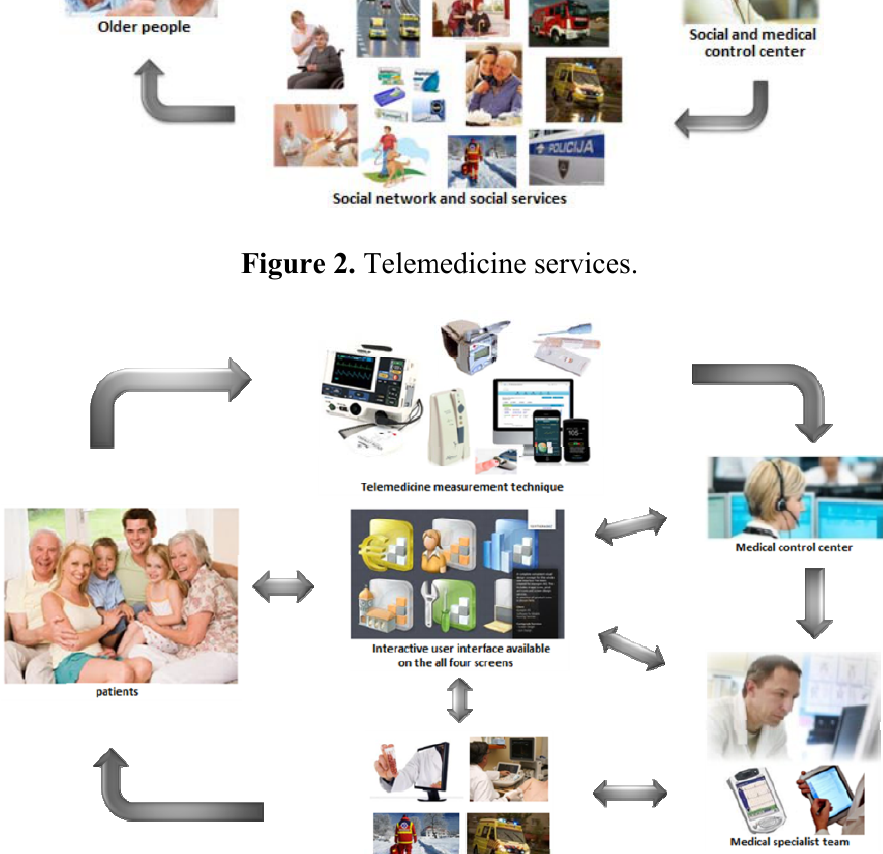
Figure 2. Telemedicine